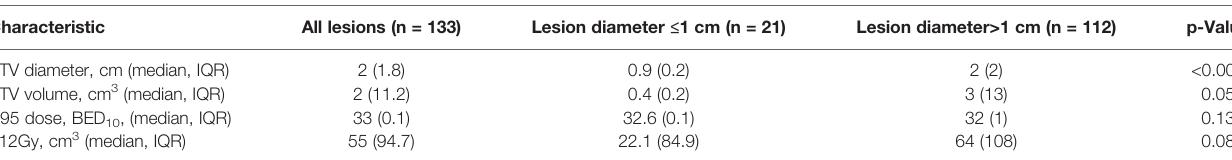
TABLE 2 | Dosimetric